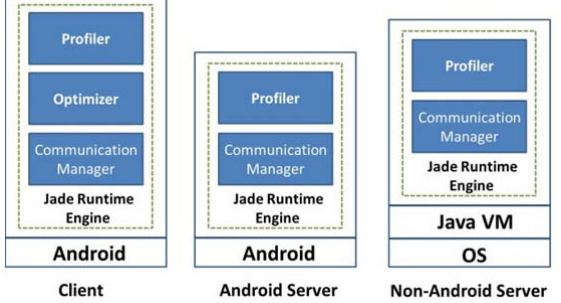
Figure 2: High-level design of the Jade runtime engine. Jade runtime engine supports Android/non-Android device. Section 4 details the components of the Jade runtime en-